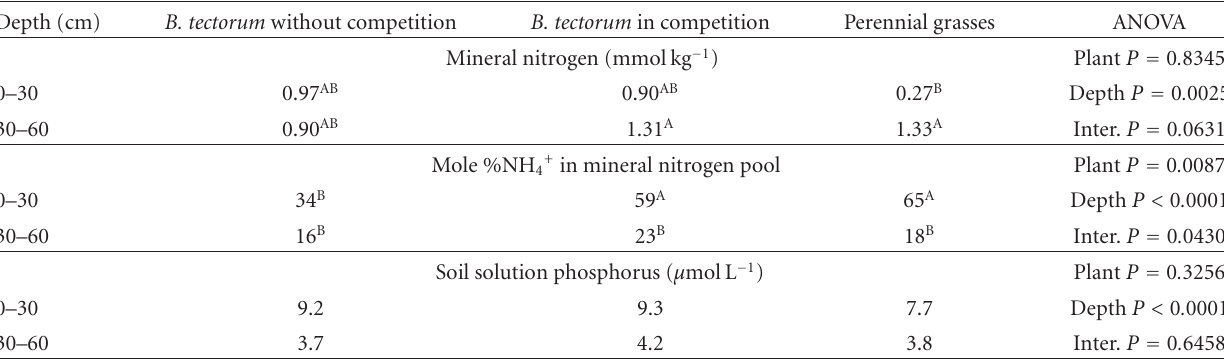
Table 6: Selected soil nutrient measurements following the 5th